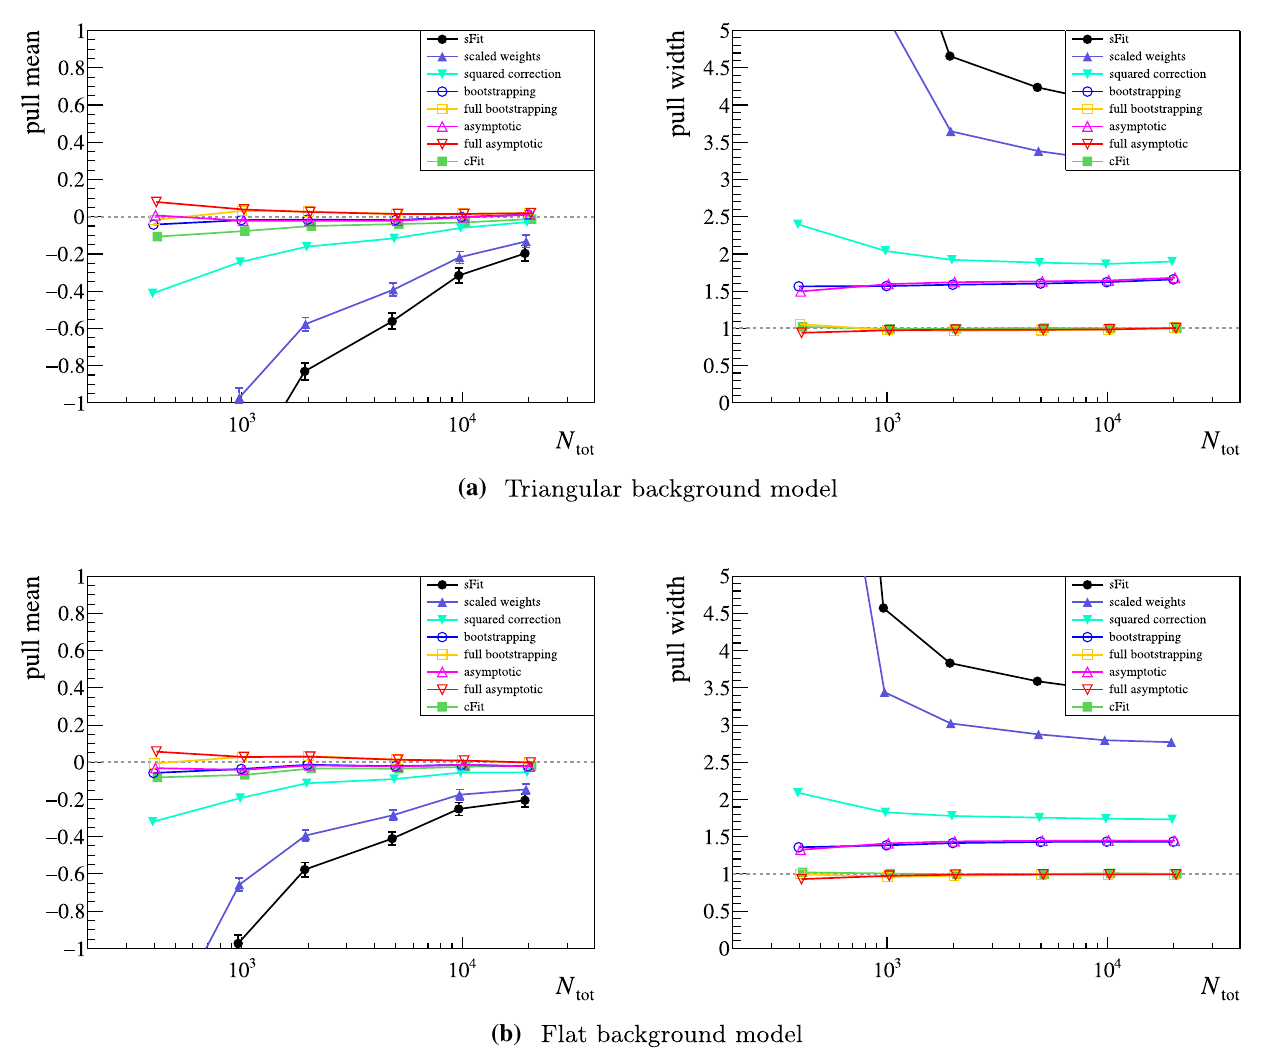
Fig. 11 (Left) Pull means and (right) pull widths depending on total event yield N tot . The markers are slightly horizontally staggered to improve